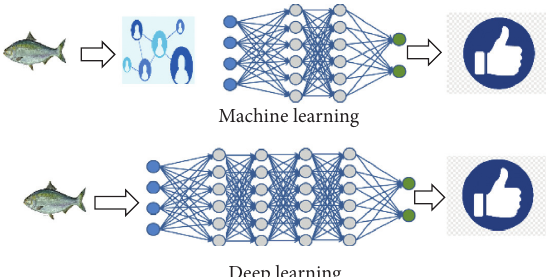
Figure 2: Difference of machine learning and deep learning in feature combination techniques.